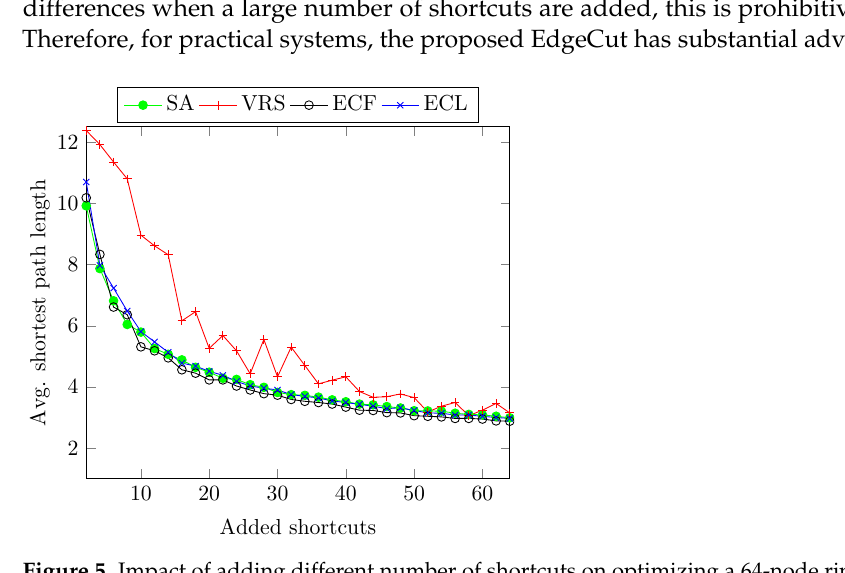
Figure 5. Impact of adding different number of shortcuts on optimizing a 64-node ring network. ECF and ECL achieve similar or lower ASPL than SA with a fraction of the search